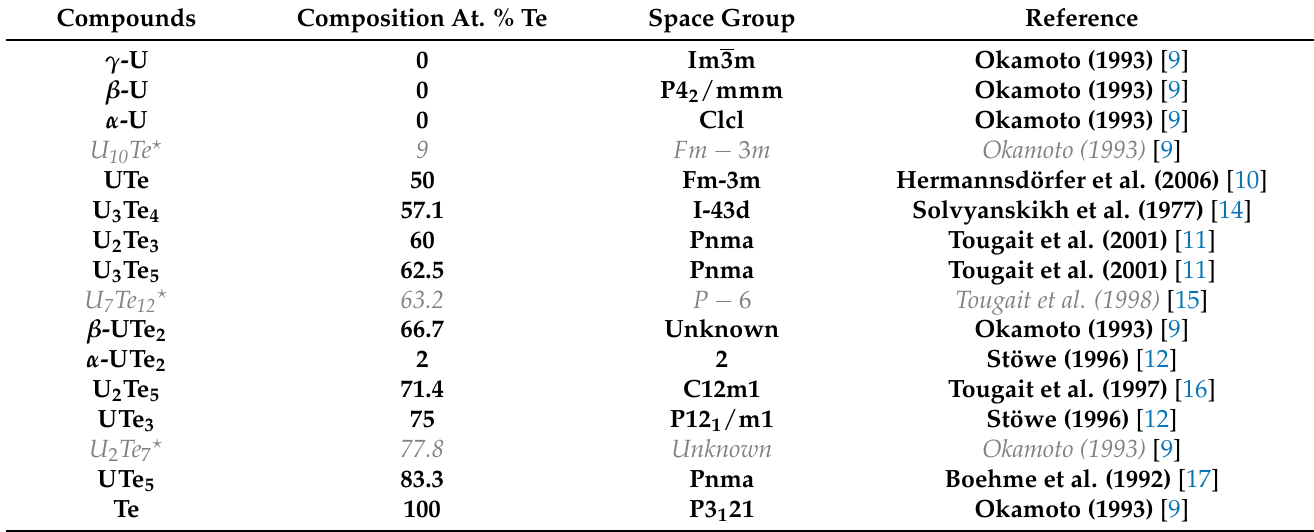
Table 1. Crystal structure data on the phases of the U–Te system. The compounds in bold are considered in the present work. The compounds in italic gray (cid:63) are not taken into account. Compounds Composition At. % Te Space Group